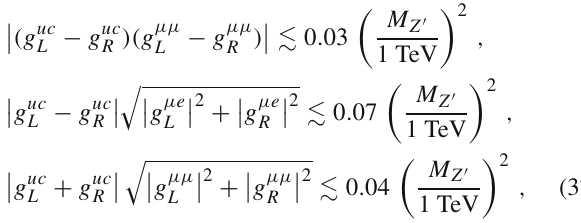
| = | K (cid:3) | = 0 . 5 (cyan), for two R- 9 10